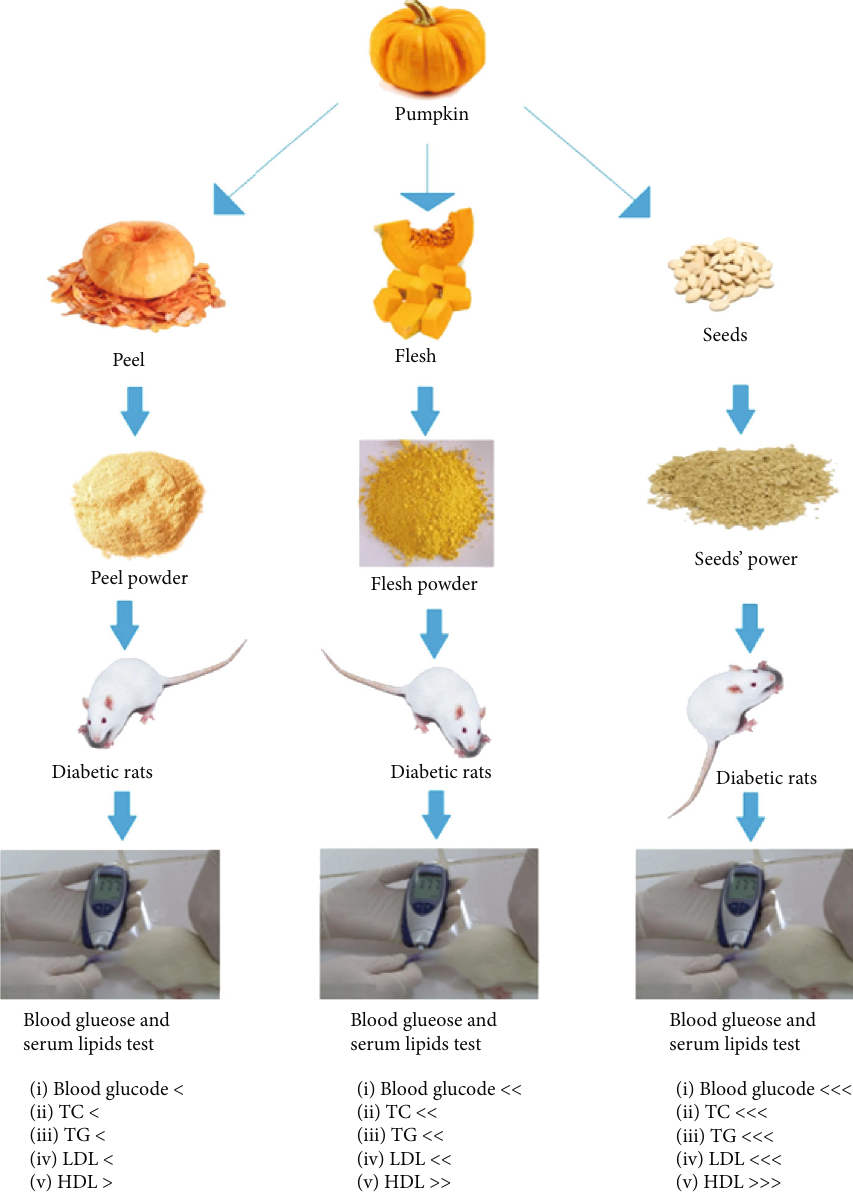
Figure 2: Graphical overview of research